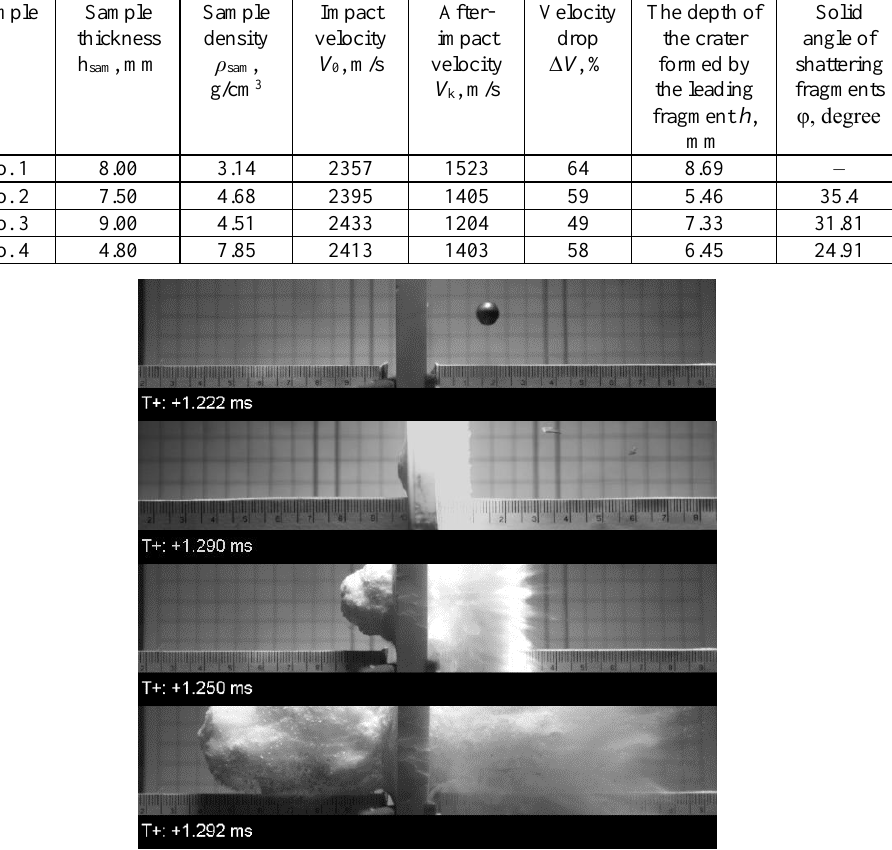
Table 2. The results of the second series of ballistic tests